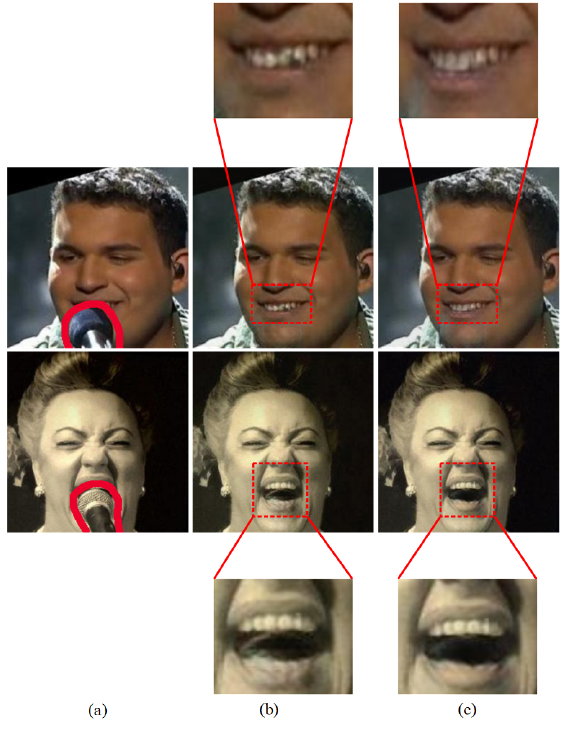
Figure 8. The effect of providing Mic images again as the input of the refiner network. ( a – c ), input mic images I mic , refiner output with the result of the inpainter network only, and refiner output with Mic images as well as the output of inpainter